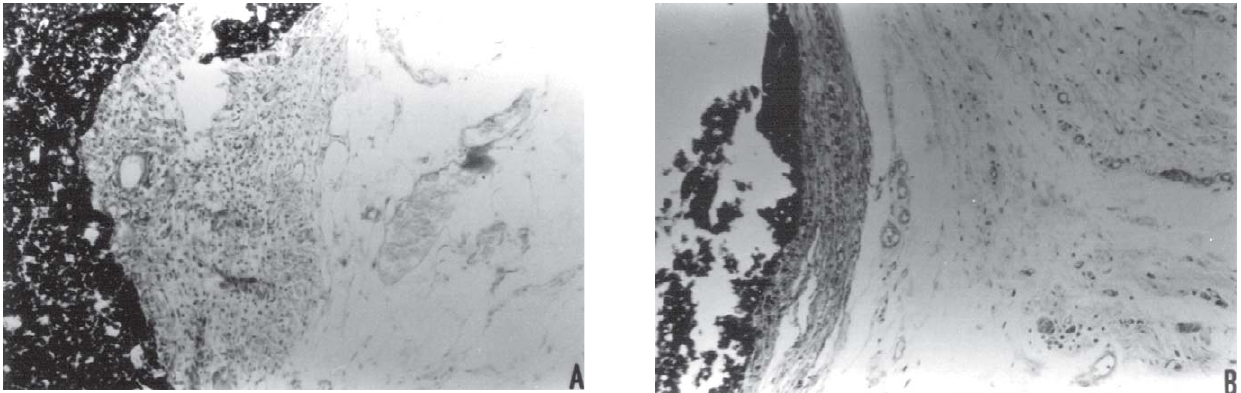
FIGURE 1- Response of the connective tissue in contact with Sealapex cement (arrows): 14-day experimental period (A) and 90-day experimental period (B). (40x)